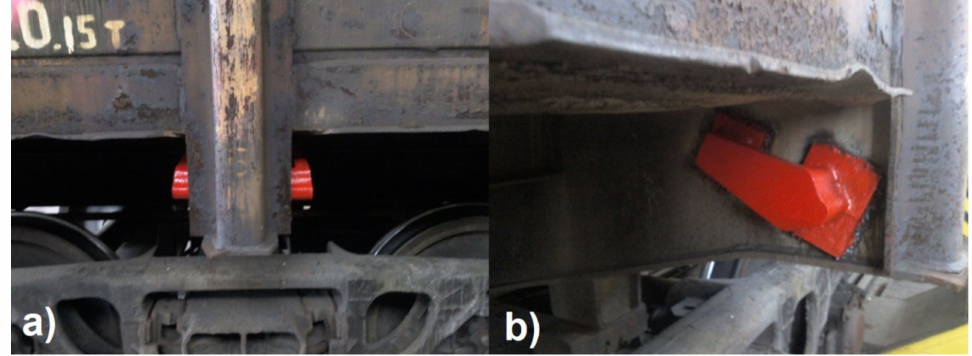
Figure 10. Location of fixation units on the bolster beam for securing a rail car on the deck ( a ) front view; ( b ) side